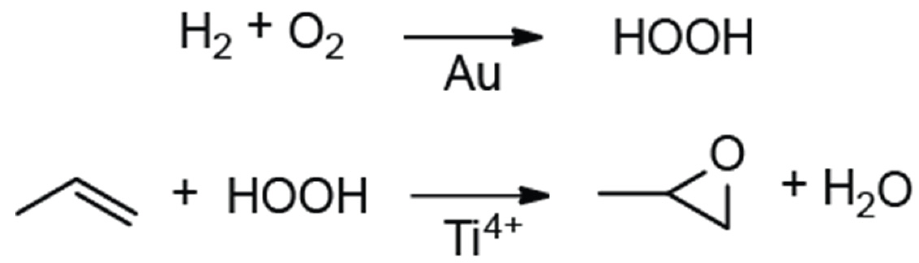
Scheme 1. Reaction mechanism of Au-Ti catalyzed propene